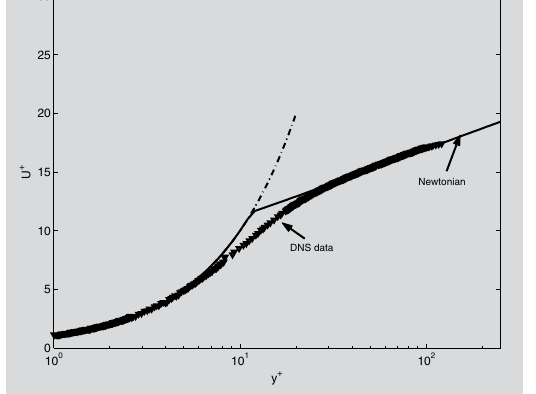
Figure 5: Comparison of mean veloci- ty profile of Newtonian flow in a channel from phenome- nological model (lines) with DNS data (symbols) of [21], with the value of parameter a = 0.26 from best overall